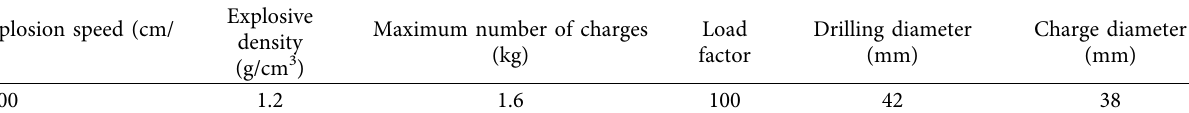
Figure 3: Numerical Table 2: Dynamite parameter.